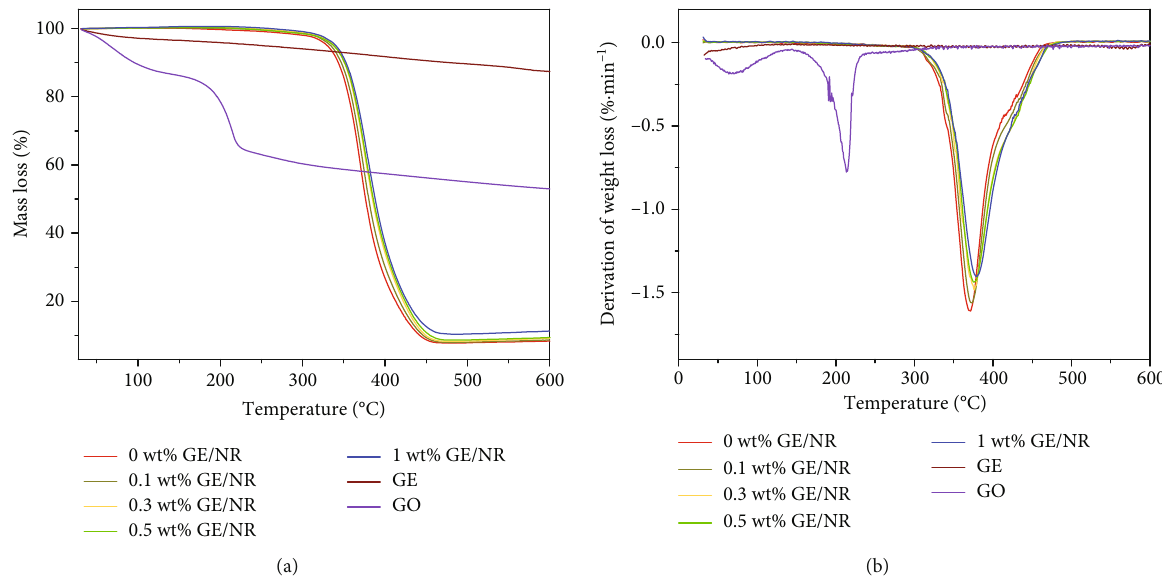
Figure 2: (a) TG and (b) DTG curves of GO, GE, and GE/NR composites in nitrogen atmosphere.